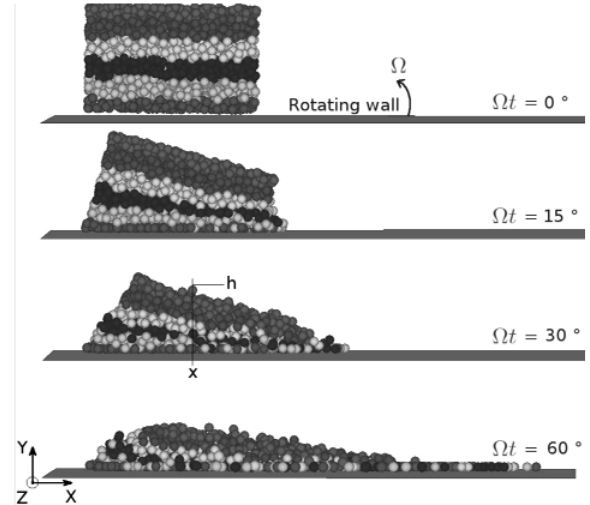
Figure 2. Schematic view of the flow at four angular